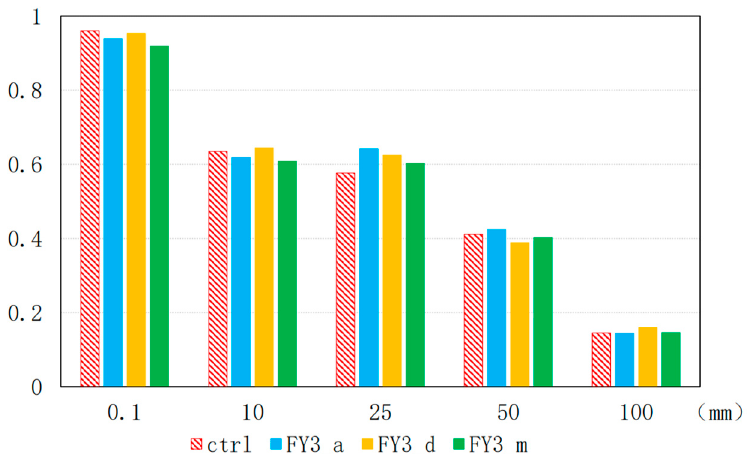
Figure 12. The threat scores of 24 h accumulated rainfall from 0600 UTC 24 to 0600 UTC 25 July for the four experiments at 0.1, 10, 25, 50 and 100 mm precipitation thresholds.